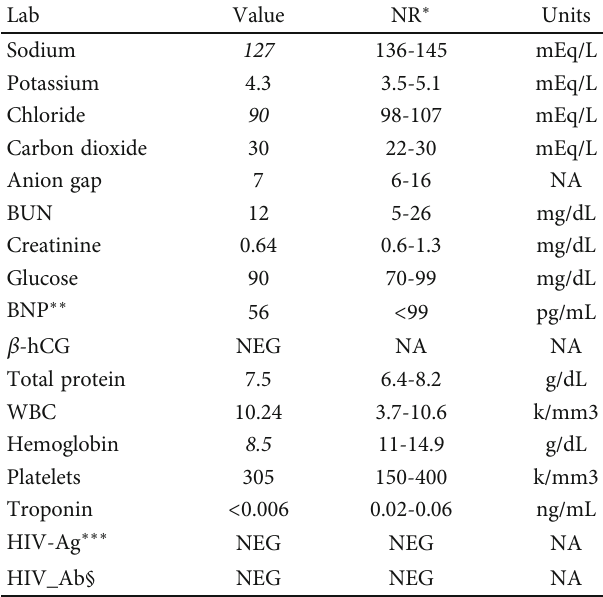
Table 1: Initial laboratory studies. Abnormal values are italicized. Lab